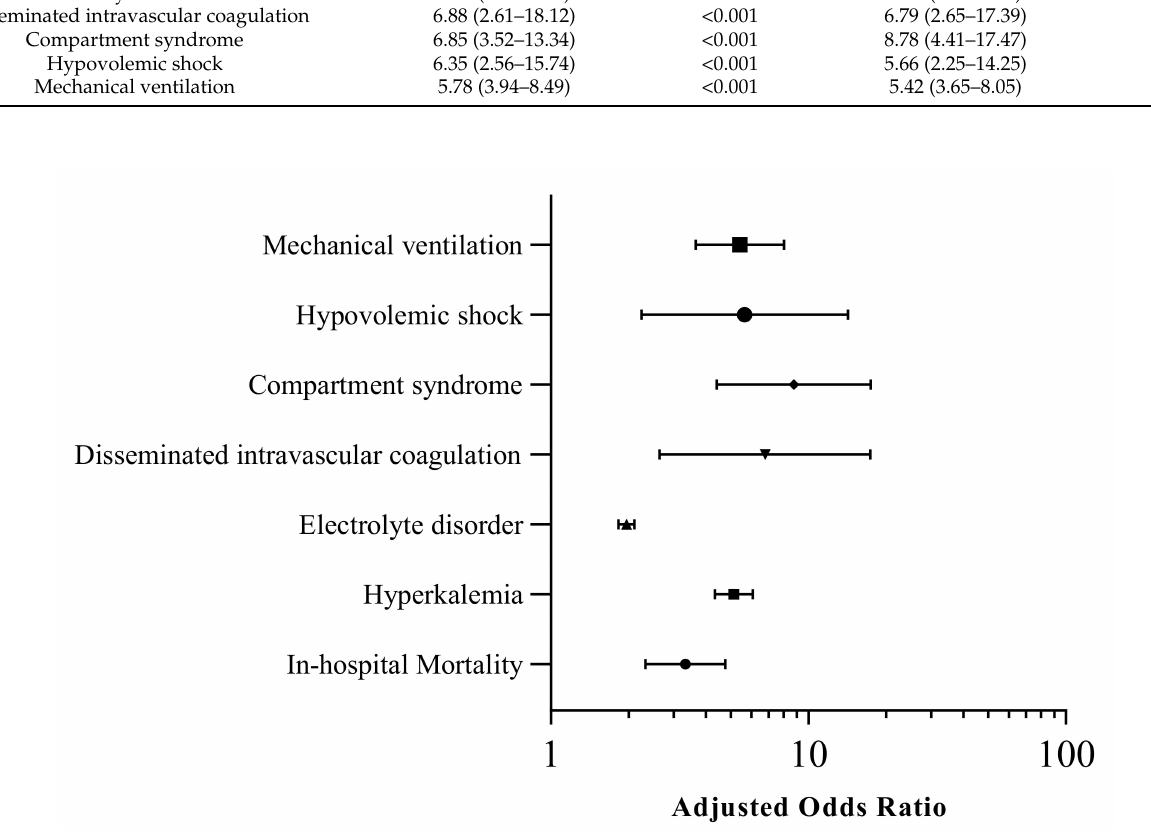
Figure 1. Multivariable logistic regression model showing effect of AKI on mortality and complications in rhabdomyolysis- related